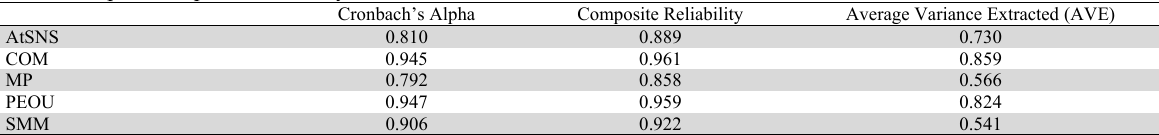
Cronbach alpha, composite reliability and AVE